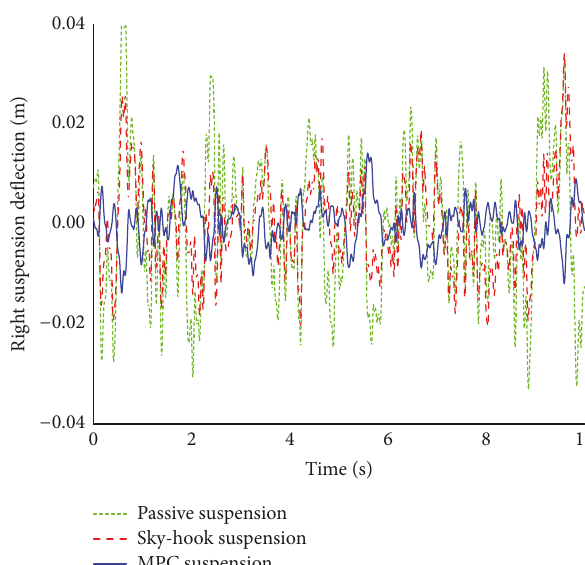
Figure 3: Pitch acceleration.